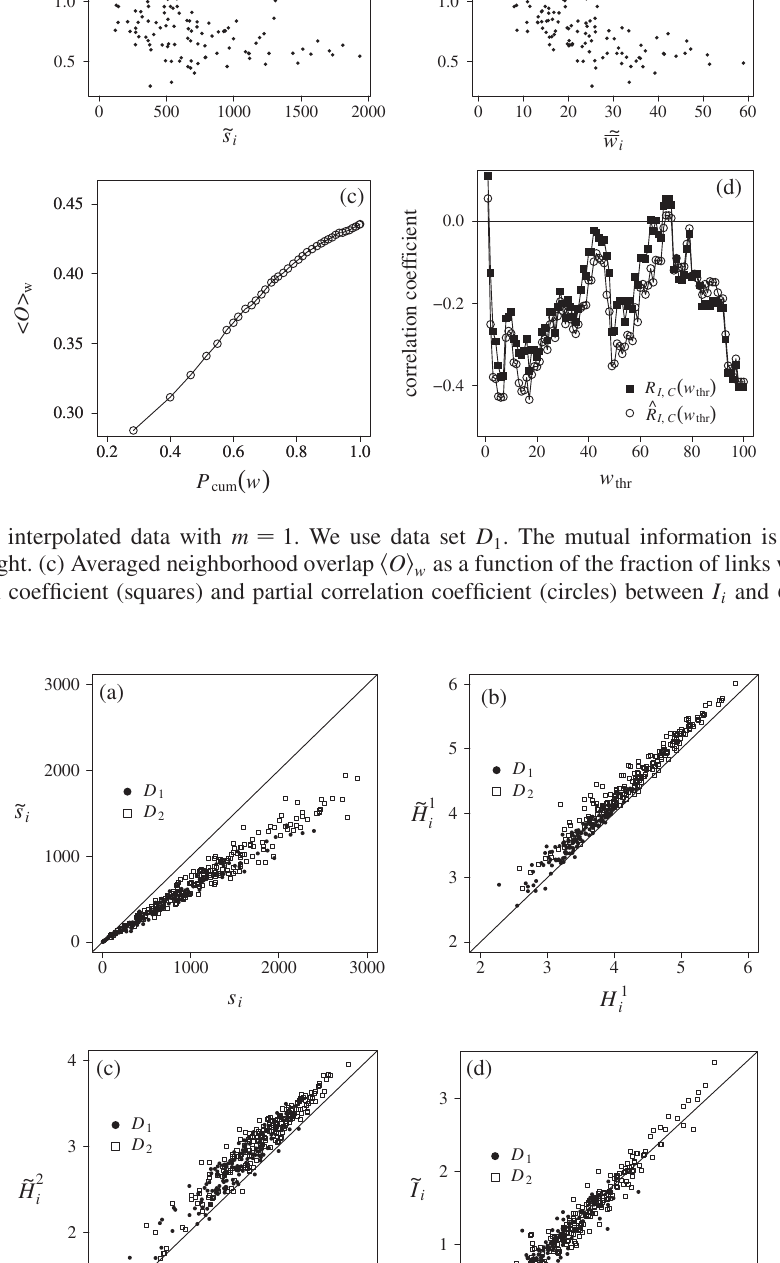
and D . (a) Node strength, (b) uncorrelated entropy, 1 2